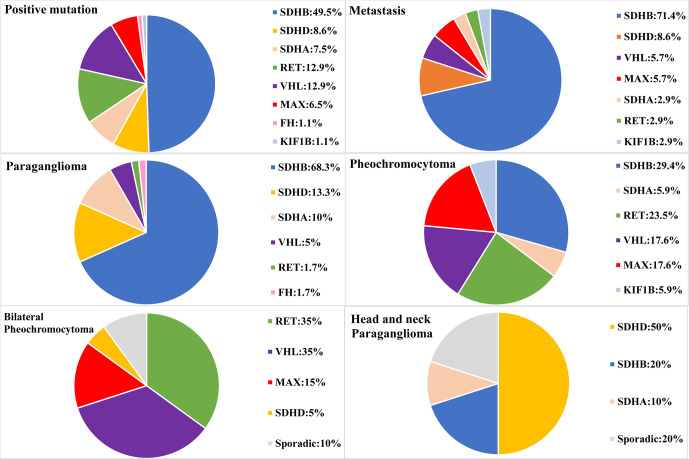
Genetic characteristics of PPGL patients with different phenotypes. Circular statistical graphic was used to illustrate the proportion of mutated gene in different clinical characteristic of PPGL.